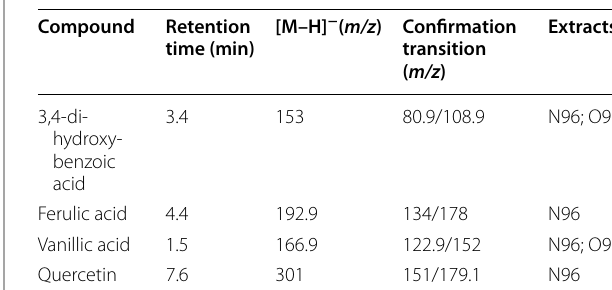
Fig. 3 TPC variation during lentil fermentation using A. oryzae LBA01 and A. niger LBA02 after 0 (nonfermented), 24, 48, 72 and 96 h